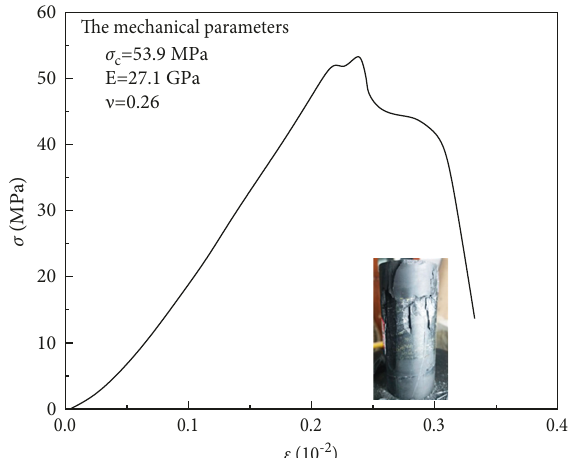
Figure 15: Division of surrounding rock destruction areas. Figure